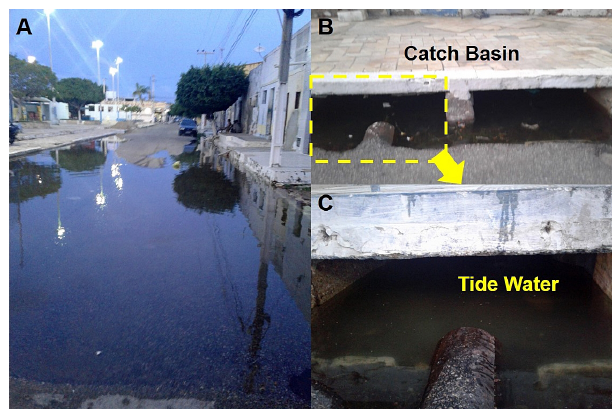
Figure 7. Tidal flood through the rain drainage system: (a) tidal flooding event on 10 March 2020 (Macau urban area); (b) example of local catch basin; and (c) catch basin in detail.